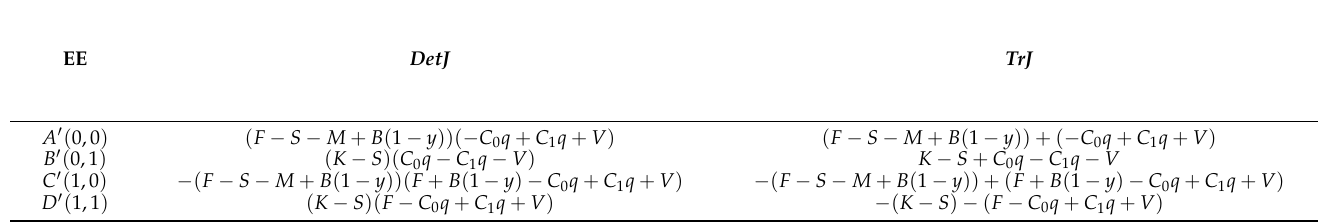
Table 6. Expressions of DetJ and TrJ at the evolutionary equilibriums under dynamic subsidy.